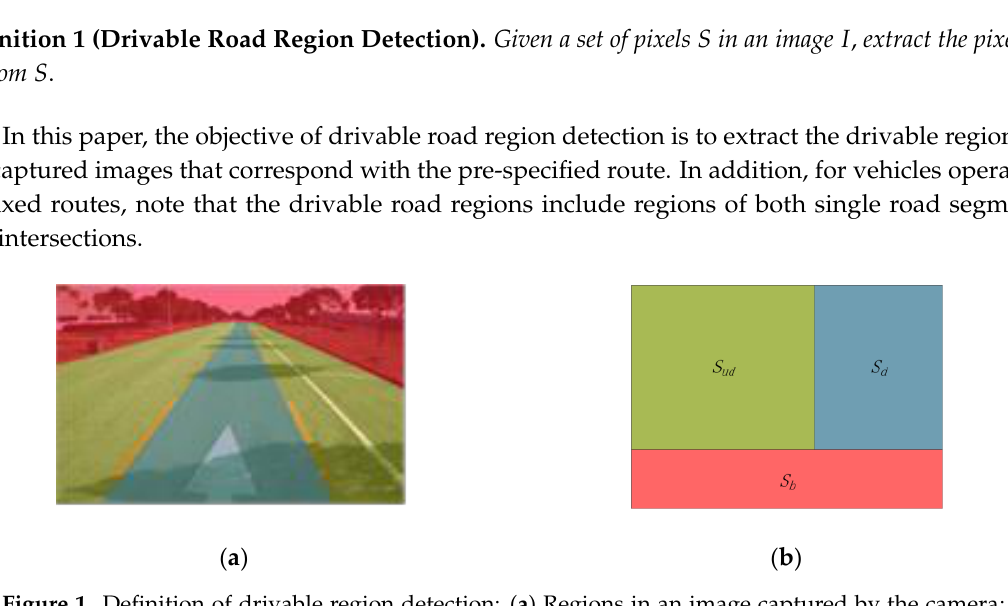
Figure 1. Definition of drivable region detection: ( a ) Regions in an image captured by the camera; ( b ) Relationship between the regions.